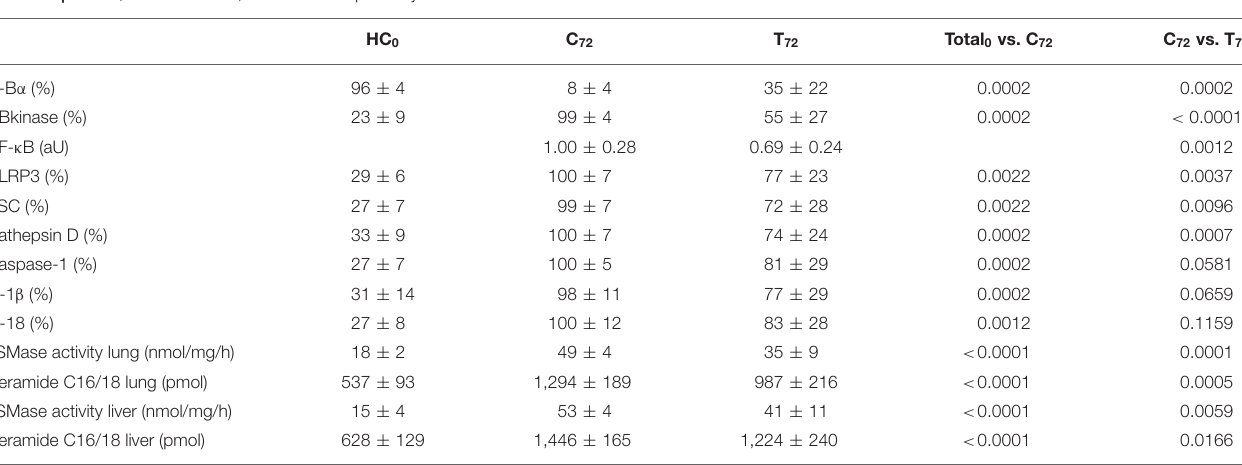
TABLE 9 | NF- κ B, inflammasome, and ceramide